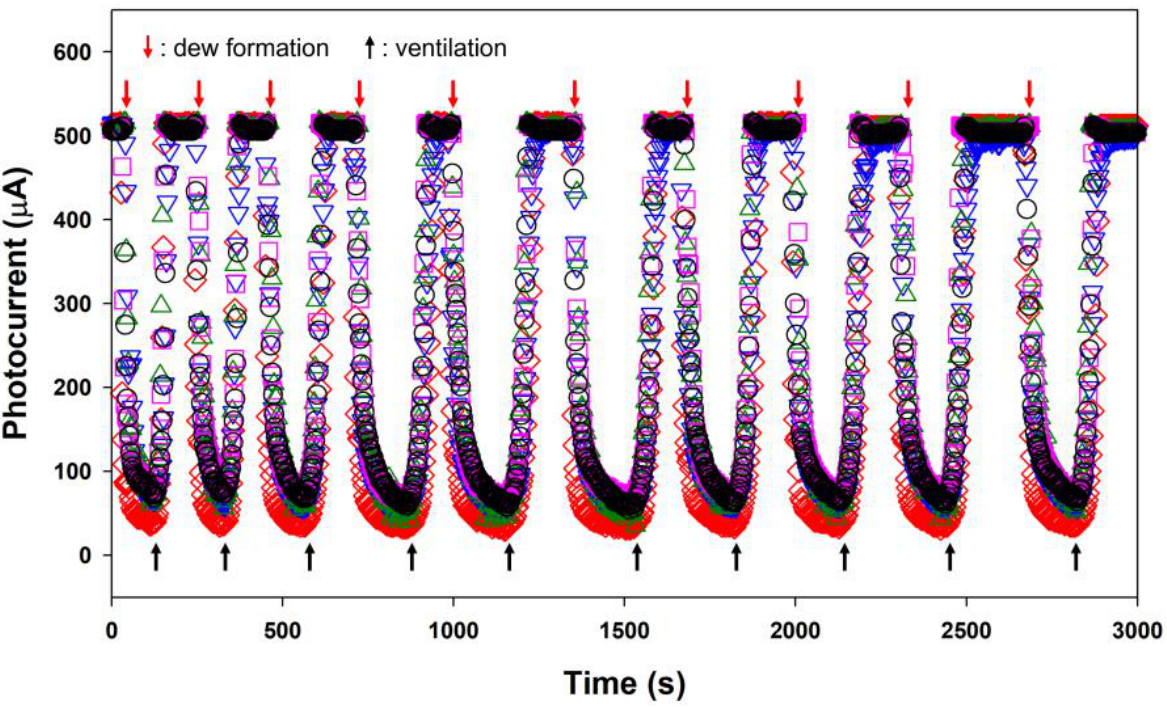
Figure 7. Responses of the five actual sensors with the water-filled waveguides to dew condensation.